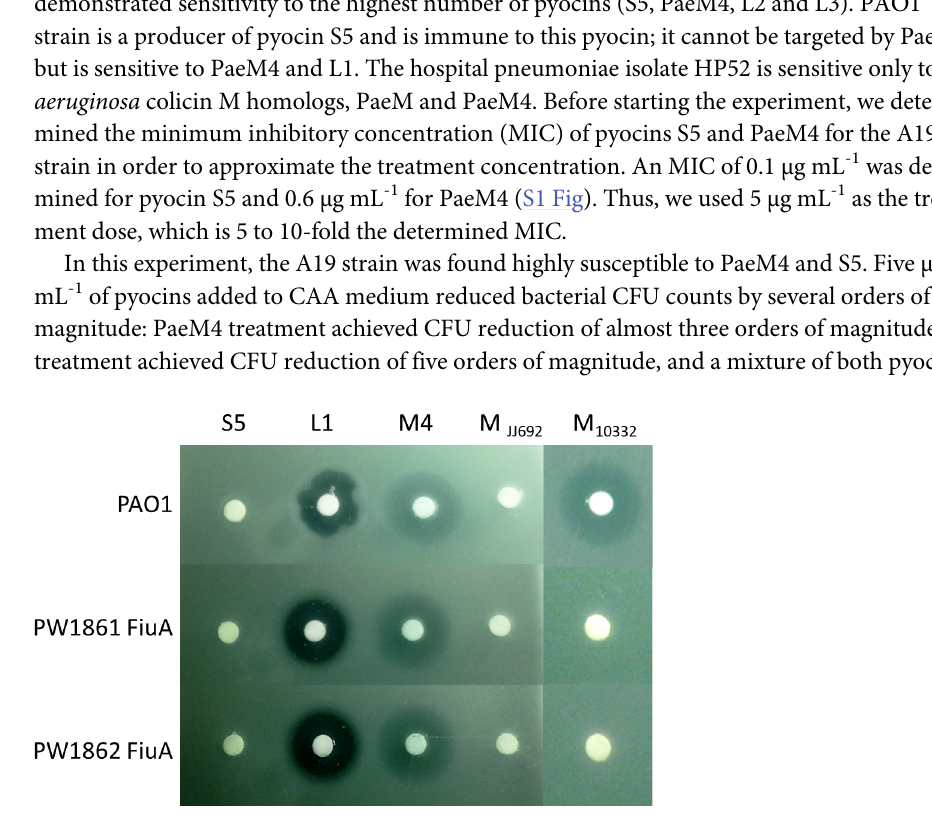
Fig 5. Sensitivity of PAO1 and PAO1 (FiuA) to pyocins. Plant-produced pyocins S5, L1, PaeM4,